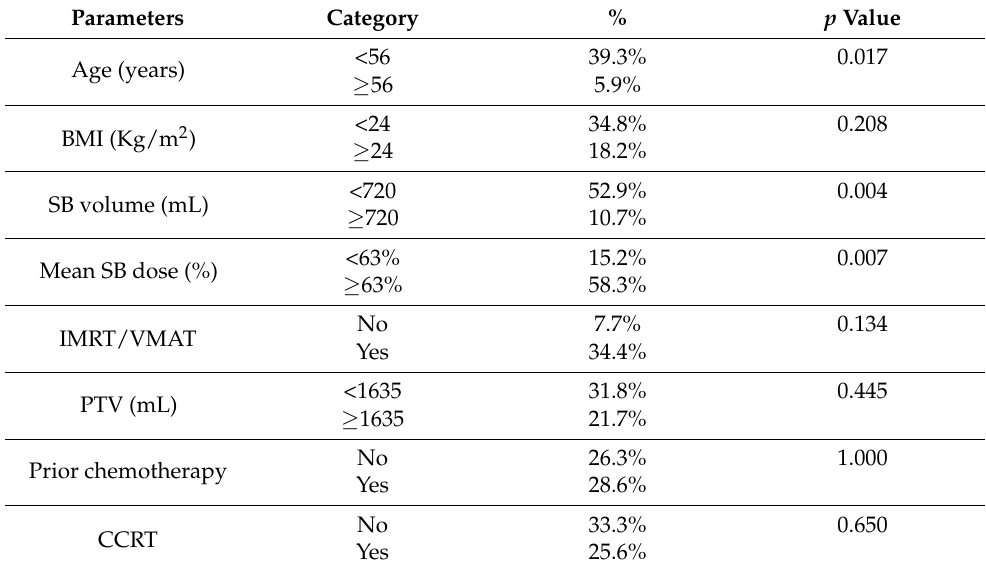
Figure 2. ( a ) Mean SB dose and ( b ) SB volume in patients without and with RIE. Table 2. Univariate analyses of